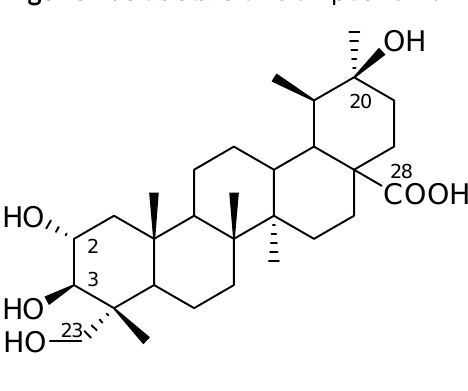
Figure 1. Structure of Compound